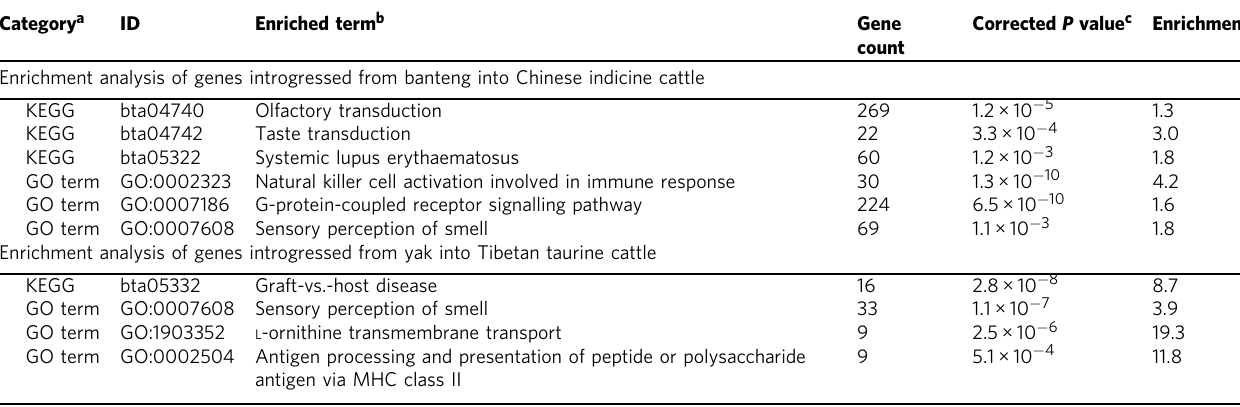
Table 1 Summary of the results from the enrichment analysis of genes introgressed from banteng into Chinese indicine cattle or from yak into Tibetan taurine cattle Category a